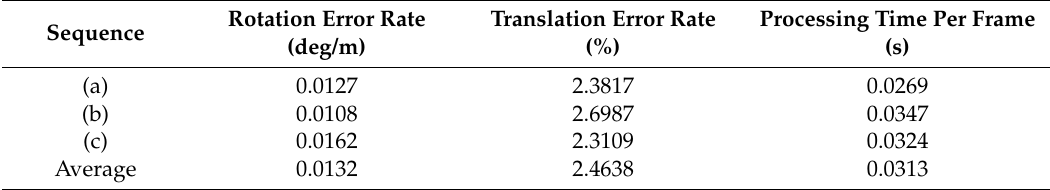
Table 4. Pose estimation accuracy for three